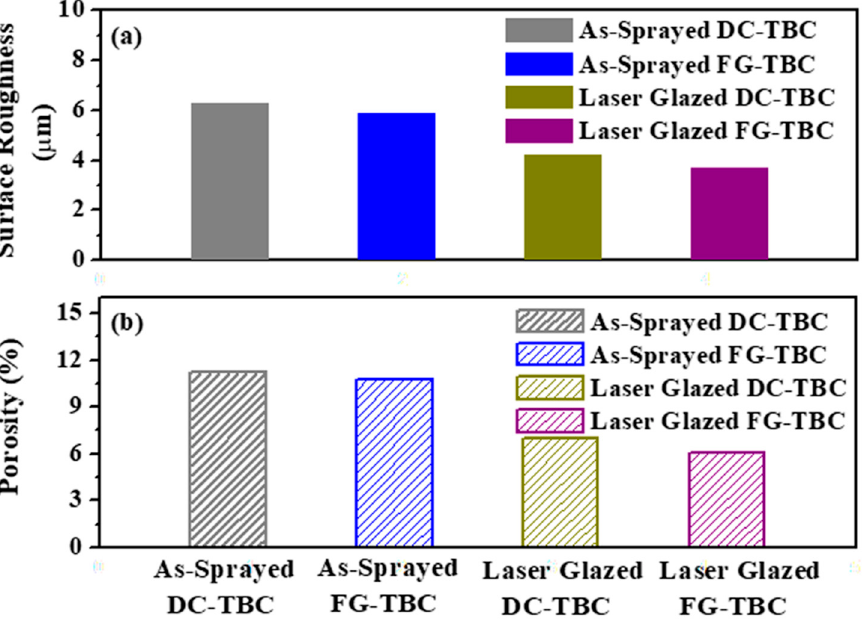
Figure 5. ( a ) Surface roughness ( µ m) and ( b ) surface porosity (%) of as-sprayed and laser-glazed coating surfaces.